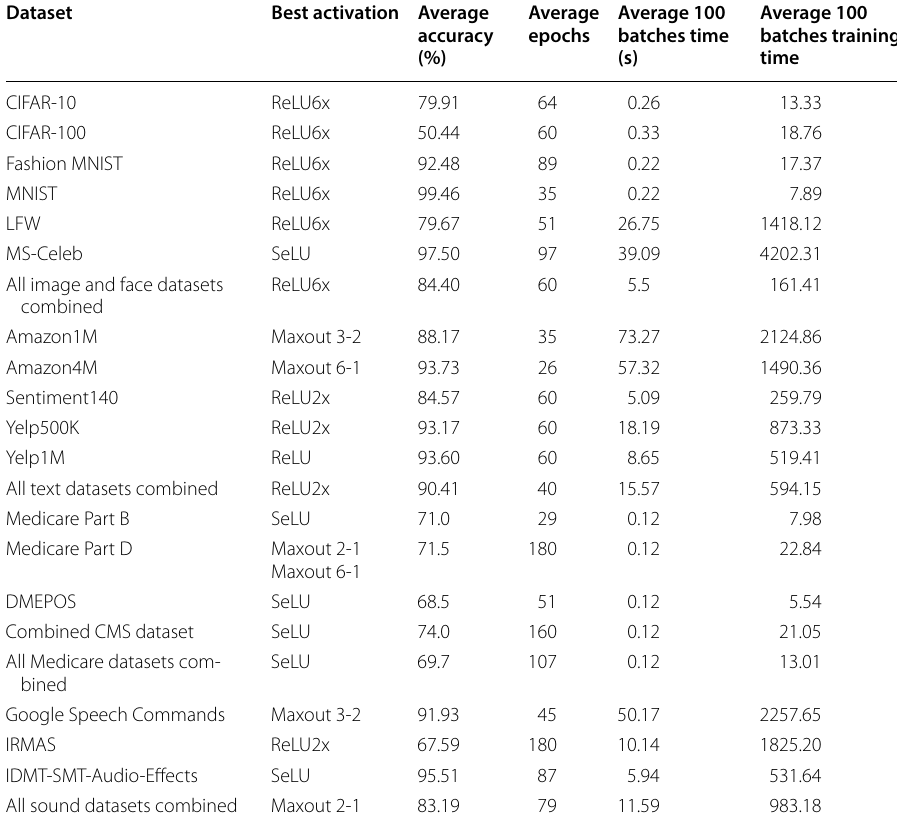
Table 7 Best activation and its results per dataset Dataset